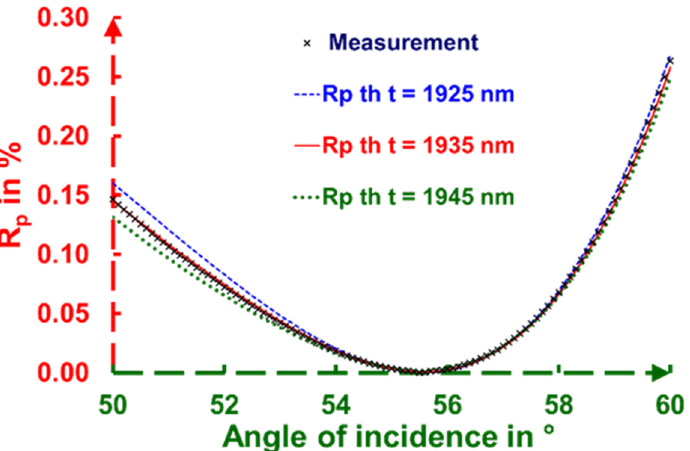
Figure 12. Comparison between an angular measurement and its fit (“th” stands for theoretical) corresponding to a local thickness t = 1935 nm of the PDMS-based ormosil layer. We had two other examples of R p calculation for a thickness t = 1945 nm and t = 1925 nm to indicate the measurement accuracy of the setup (<10 nm).